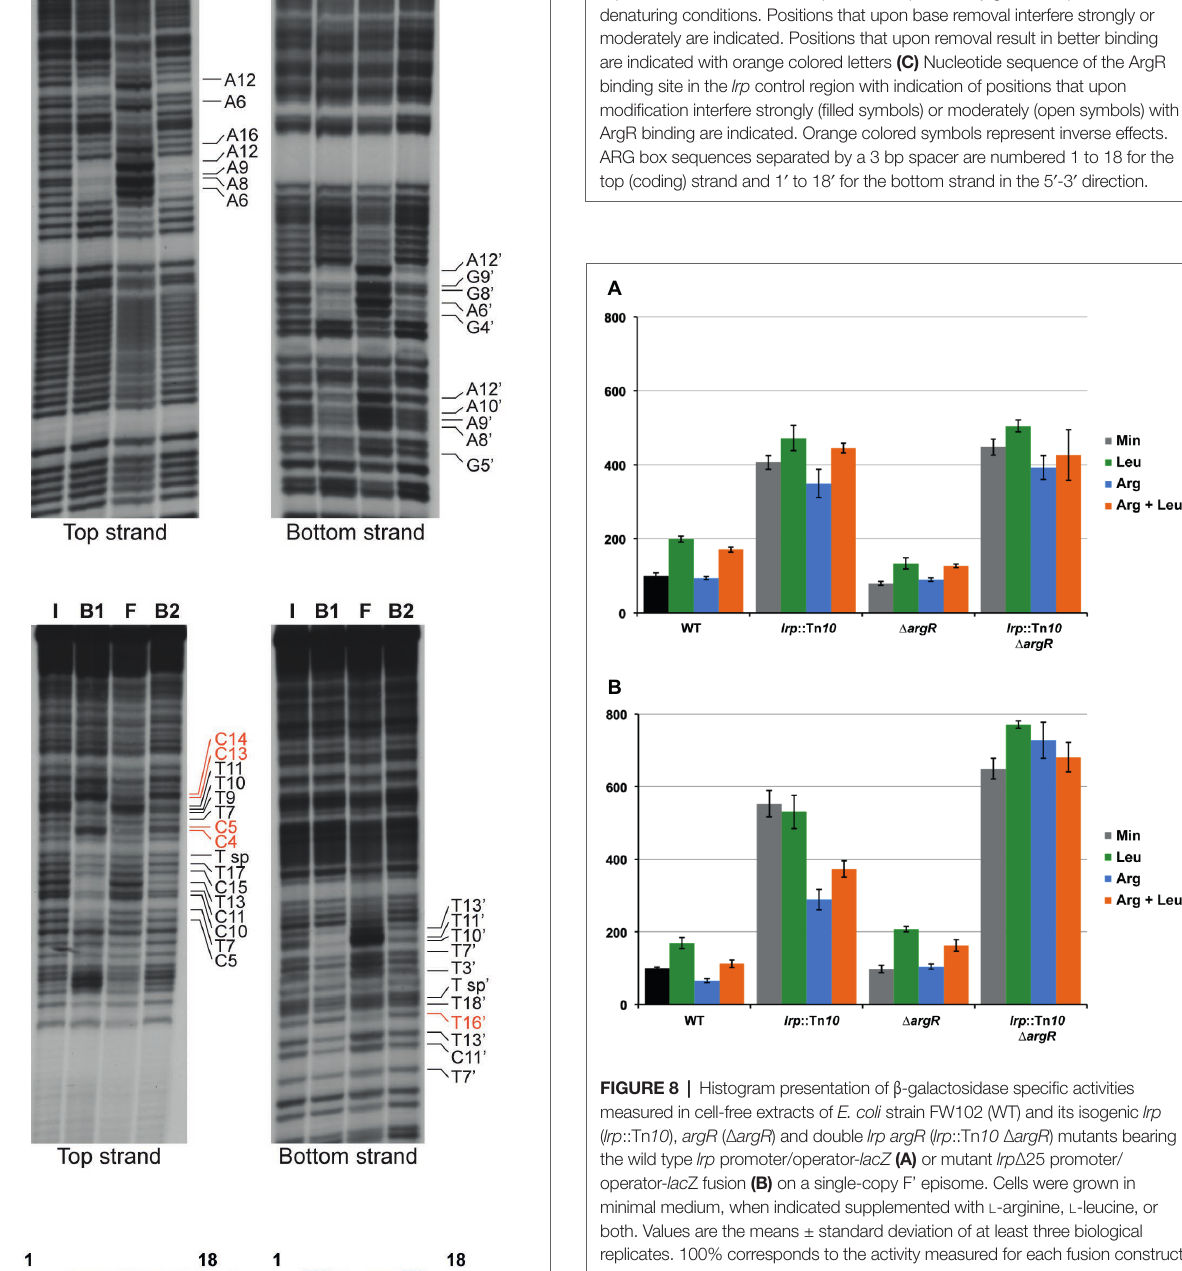
FIGURE 7 | modified DNA molecules incubated in the absence (I = input) and in the presence of various concentrations of ArgR, resulting in approximately 50% binding for F1 and B1, and > 90% for F2 and B2, were separated on basis of their affinity for the protein by gel electrophoresis in native conditions, extracted from gel, cleaved at the positions of modification with piperidine and equal amounts of the reaction products separated by gel electrophoresis in denaturing conditions. Positions that upon base removal interfere strongly or moderately are indicated. Positions that upon removal result in better binding are indicated with orange colored letters (C) Nucleotide sequence of the ArgR binding site in the lrp control region with indication of positions that upon modification interfere strongly (filled symbols) or moderately (open symbols) with ArgR binding are indicated. Orange colored symbols represent inverse effects.